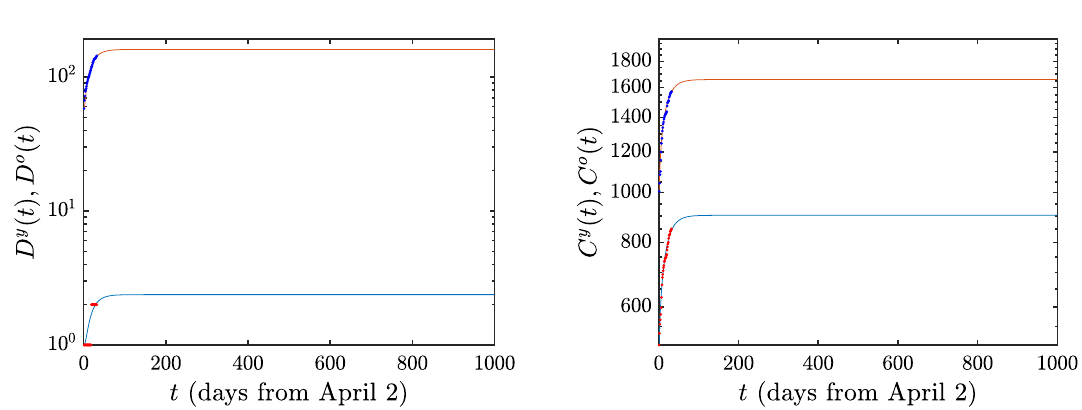
Figure 2. Evolution of the current situation of deaths D ( t ) (left) and cumulative infections C ( t ) (right) in Greece, under the case of an indefinite continuation of the lockdown conditions. In this and all the figures that follow, the blue curve corresponds to the young population, while the red curve to the older population. The data for Greece from the 3rd of April to the 4th of May 2020 are depicted by dots. For the latter, alternate colors have been used (i.e., blue dots for the older population and red for the younger for clearer